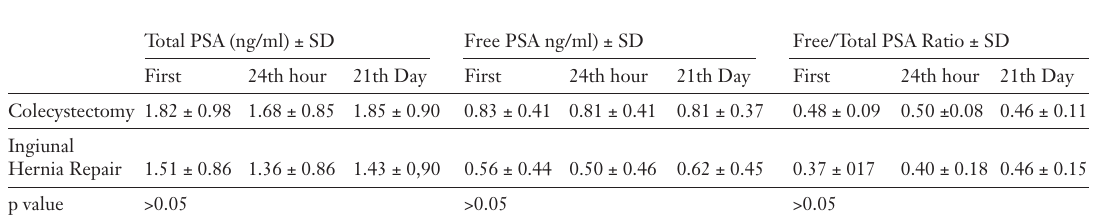
Table 1. Summary of the total PSA, the free PSA values and the f/t PSA ratios of the patients.